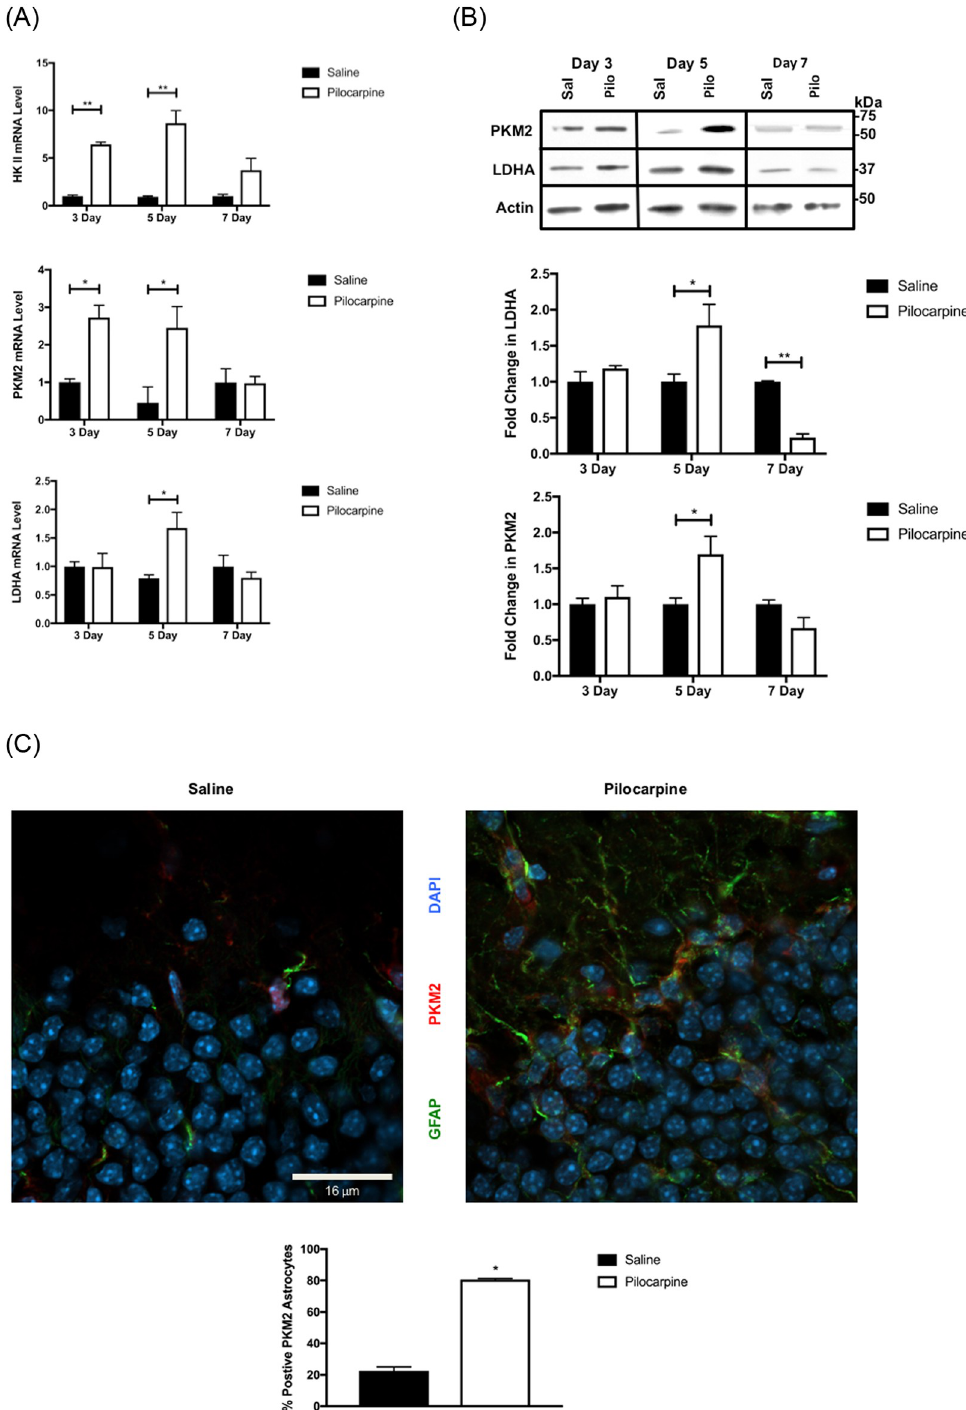
Fig 3. Status-induced Warburg metabolic enzymes. (A) The mRNA expression of Warburg metabolic enzyme isoforms is elevated after pilocarpine-induced SE. Quantitative RT-PCR was used to measure the mRNA for hexokinase 2 (HK II), pyruvate kinase M2 isoform (PKM2) and lactate dehydrogenase A-isoform (LDHA) from the hippocampi of the 3-, 5- and 7-day post-status epilepticus mice in (pilocarpine-treated) compared to control (saline) mice. (B) Protein expression of Warburg metabolic enzyme isoforms are elevated after pilocarpine-induced SE. Representative and quantified western blots of hippocampal extracts from 3-, 5- or 7-day pilocarpine (Pilo), or control saline (Sal) are shown for PKM2, LDHA,